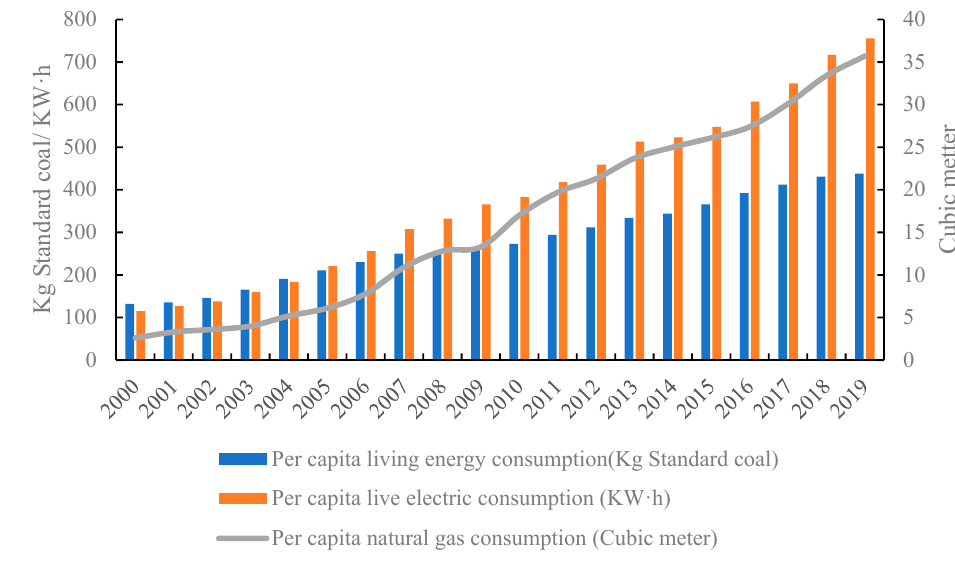
Figure 1. Domestic energy consumption of Chinese residents.